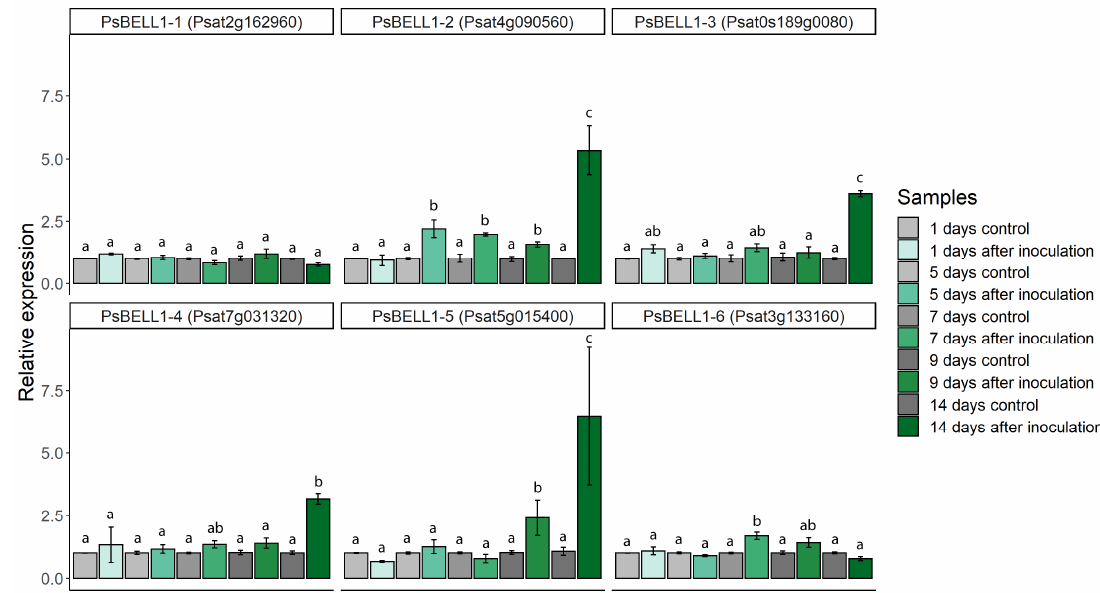
Figure 2. Expression dynamics of selected BELL genes in inoculated Pisum sativum roots (cv. Frisson) at di ff erent stages of symbiosis development. mRNA levels were normalized against Ubiquitin and values were calculated as ratios relative to non-inoculated root expression levels (control). The data of three independent biological experiments were analyzed. For one biological experiment, three technical replicates were obtained at each developmental stage. Bars represent the mean ± SEM. Di ff erent letters indicate statistically significant di ff erences between groups as analyzed by one-way analysis of variance (one-way ANOVA), followed by Tukey’s post hoc